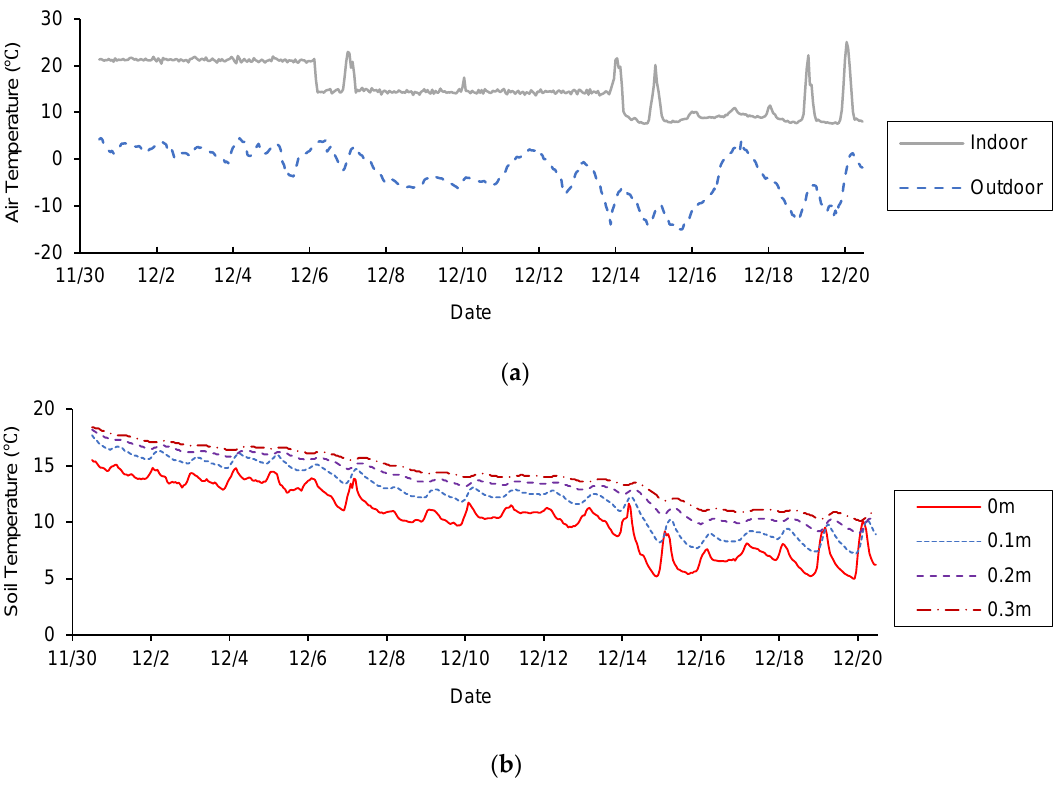
Figure 2. Diurnal variations of ( a ) air temperature and ( b ) greenhouse soil temperature during the heating season.